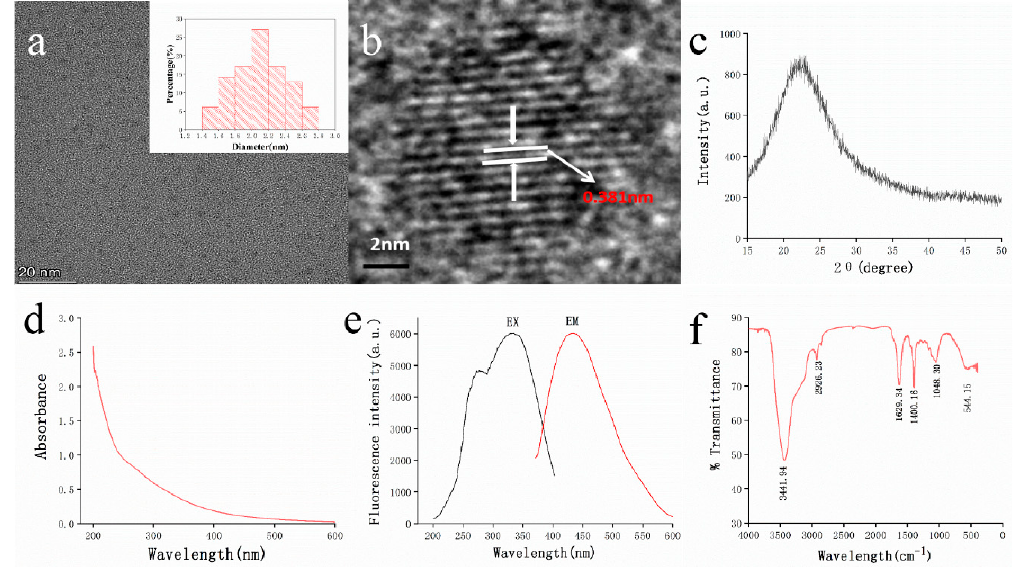
Figure 3. Characterisation of STC-NPs: ( a ) Transmission electron microscopy (TEM) images of STC-NPs displaying ultra-small particles and TEM size distribution of STC-NPs (Upper right corner). ( b ) High-resolution TEM image of STC-NPs. ( c ) X-ray di ff raction pattern. ( d ) Ultraviolet–visible spectrum. ( e ) Fluorescence spectrum. ( f ) Fourier transform infra-red spectrum.